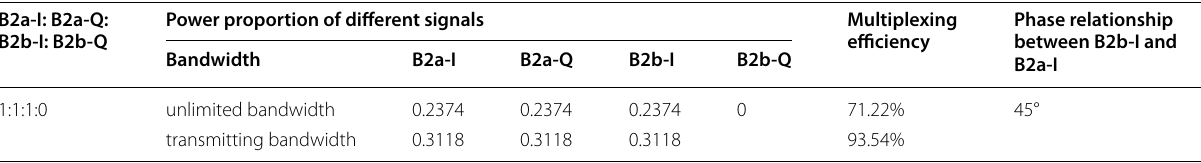
Table 5 Actual power and multiplexing efficiency of each component after phase rotation and intermodulation component suppression B2a‑I: B2a‑Q: B2b‑I: